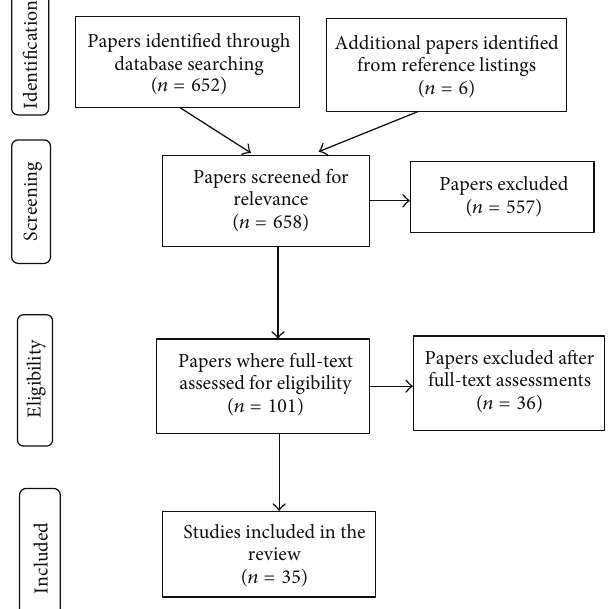
Figure 1: PRISMA Flow Diagram used in this